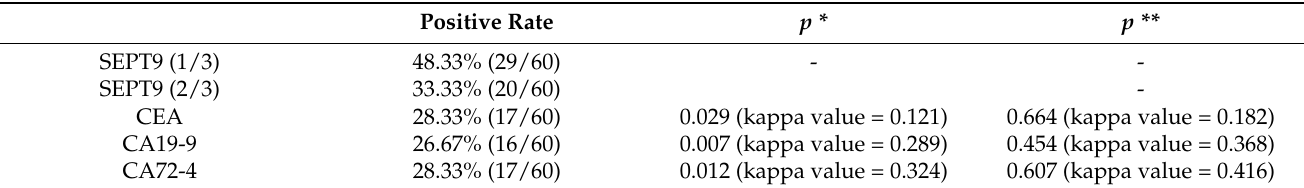
Table 4. A comparison of the positive rates of mSEPT9 and serum tumor markers in the GC group.